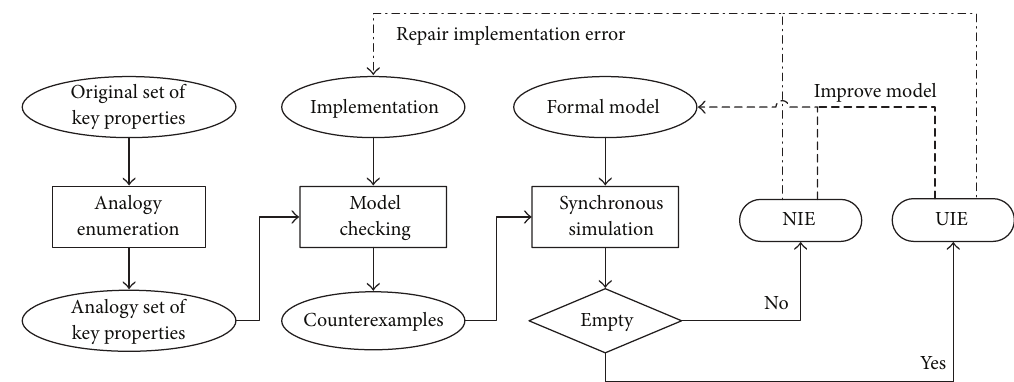
Figure 4: The framework of the LIED